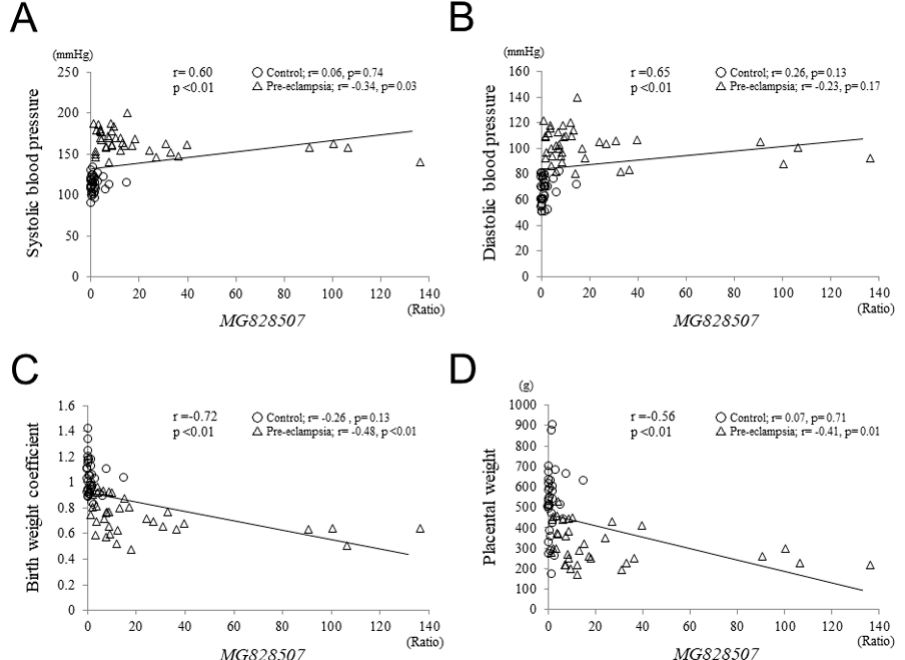
Figure 5. Correlations between MG828507 expression and systolic blood pressure ( A ), diastolic blood pressure ( B ), normalized birth weight ( C ), or placental weight ( D ). Open circles indicate control uncomplicated pregnancies, and open triangles indicate pre-eclampsia. Regression lines are shown with correlation coefficients and p values.